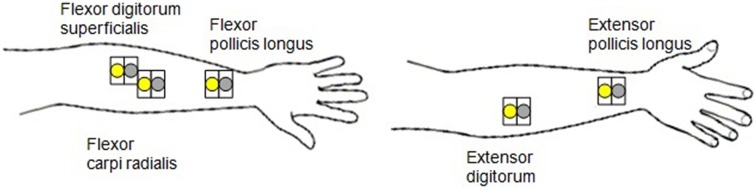
Electrode placement.